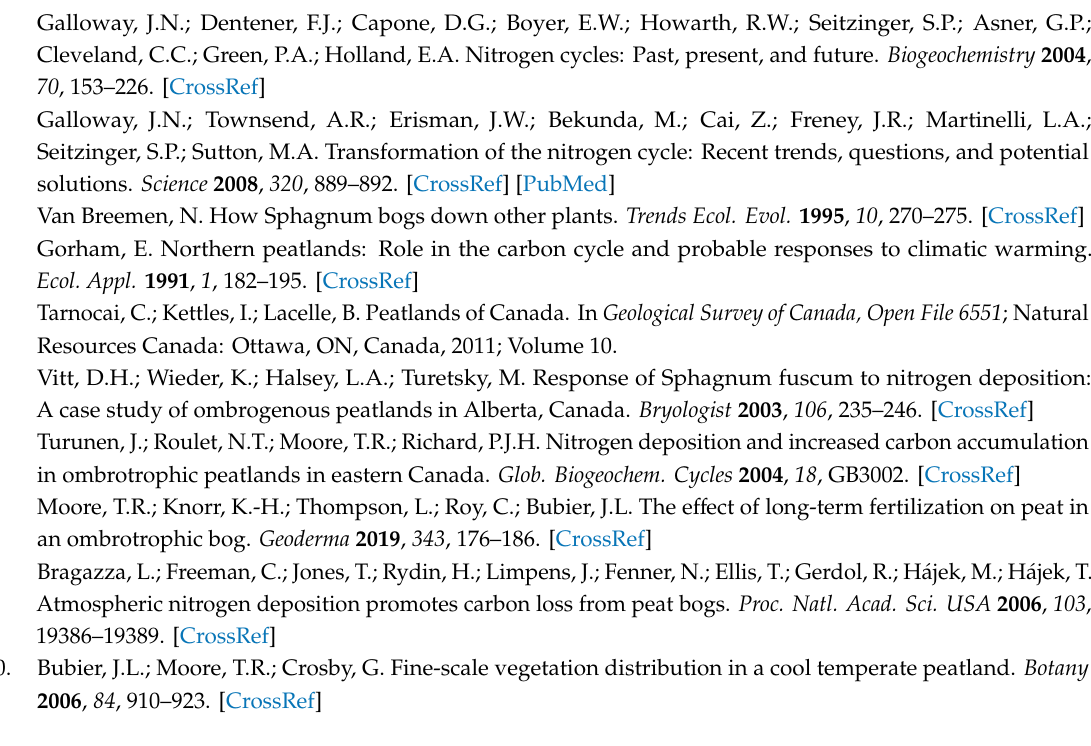
Figure S1. Location of the three ombrotrophic bogs in southern Qu é bec and Ontario (Canada): La Mer Bleue Peatland, La Grande-Tourbi è re-de-Villeroy, and La Grande-pl é e-Bleue); Figure S2. Mean values and standard error of (a) peat N concentration (%), (b) pH in the peat water, (c) Corrected electrical conductivity (EC) in the peat water, and (d) water table depth (cm) for each bog at moment of sampling; Figure S3. Custom sample mount for sampling leaf spectra of small leaves; Figure S4. Parameters (n: filter length; p: filter order) and regions (colored background) used for the Savitzky–Golay filter on leaf spectra; Table S1. References for determination of wavelength ranges used in PLSR analyses for leaf functional traits; Table S2. Statistical significance of site, species and their interactive (site:species) e ff ect in linear mixed e ff ect models for foliar traits from E. vaginatum , K. angustifolia , C. calyculata, and R. groenlandicum ; Figure S5. Mean ( ± standard error) functional traits in relation to localization and species (a) and species (b); and Figure S6. Variable importance of the predictors (VIP) of wavelengths indicating their contribution to the prediction of foliar